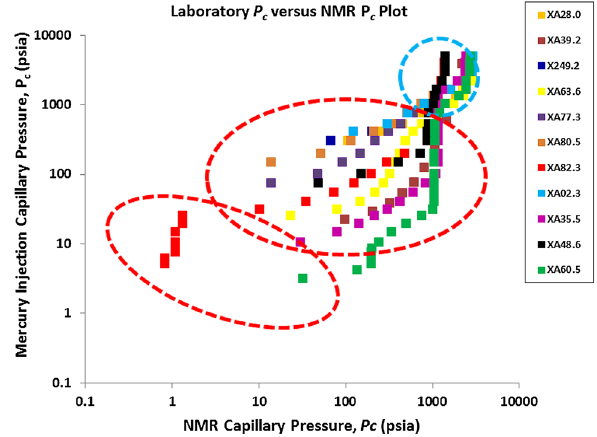
Fig. 7 Mercury injection capillary pressure curves versus inverse NMR T 2 distribution for sample dataset indicating nonlinearity in relationship